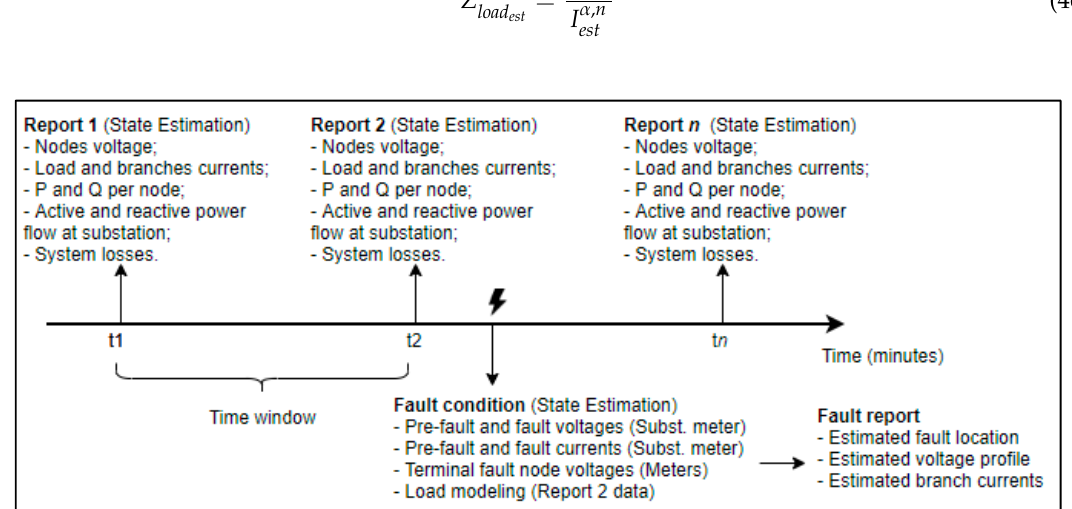
Figure 4. System supervision by the proposed linearized state estimator.